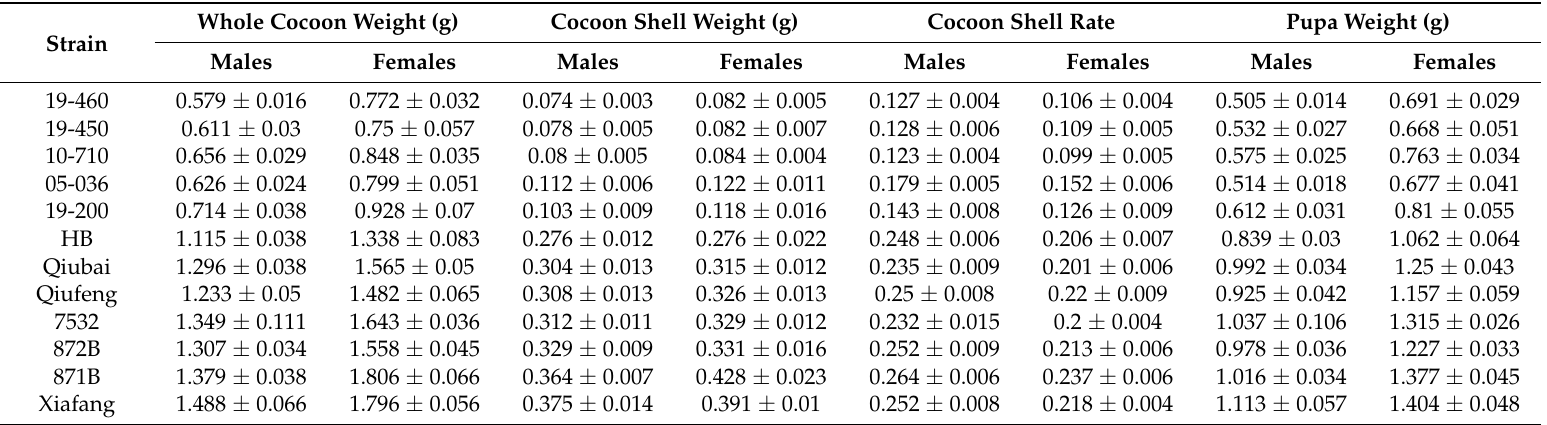
Table 1. Statistical analysis of yield-related traits in various silkworm